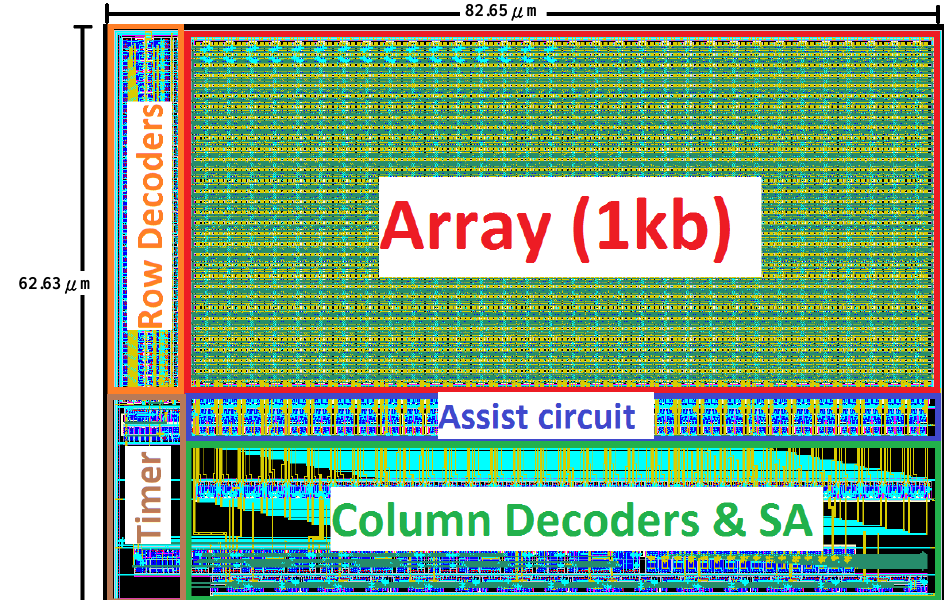
Figure 16. The 1 kb-array layout of the proposed design.